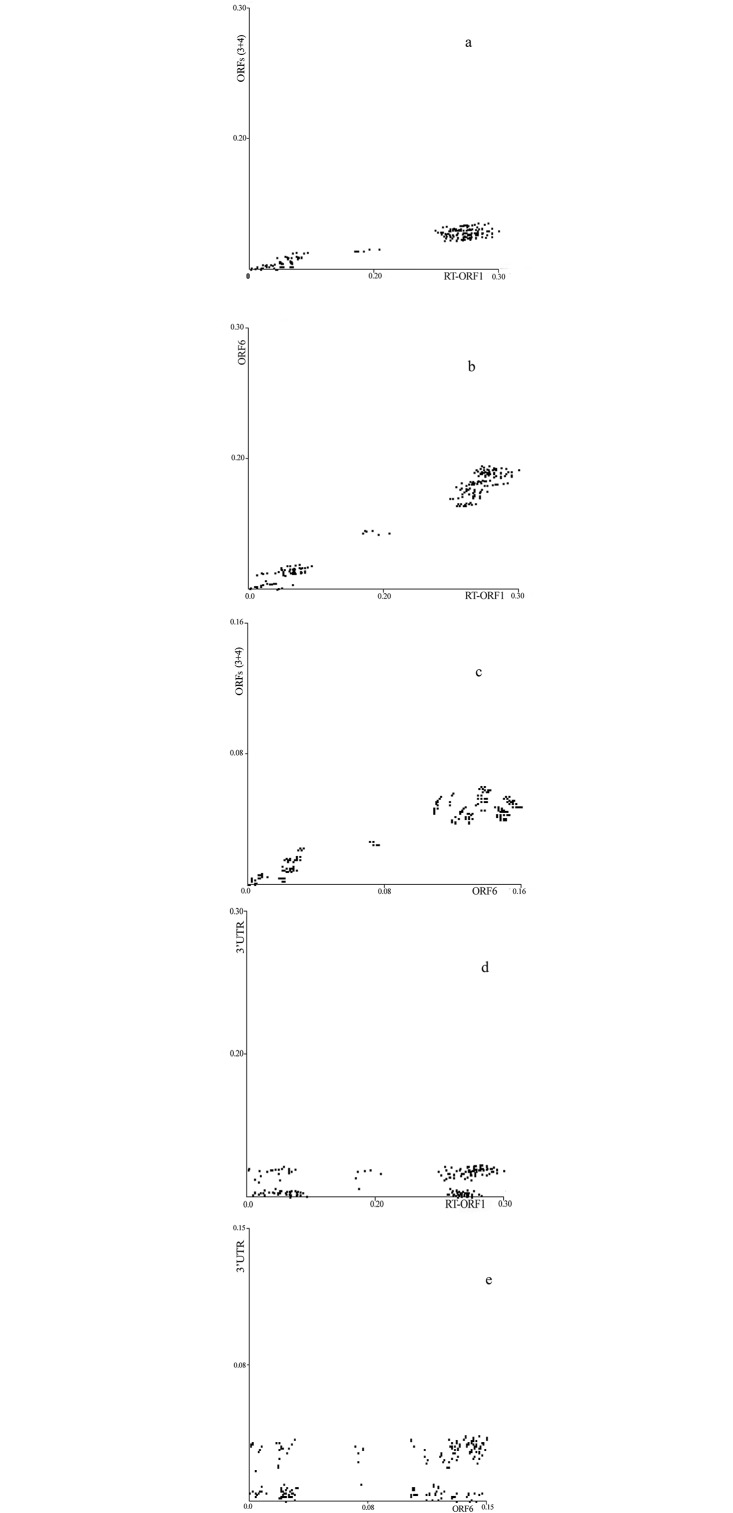
Multidimensional scaling of tree-to-tree patristic distances (a) ORFs (3+4) vs RT-ORF1 isolates; (b) ORF 6 vs RT-ORF1 isolates; (c) ORFs (3+4) vs ORF6 isolates; (d) 3′UTR vs RT-ORF1 isolates; and (e) 3′UTR vs ORF6 isolates.